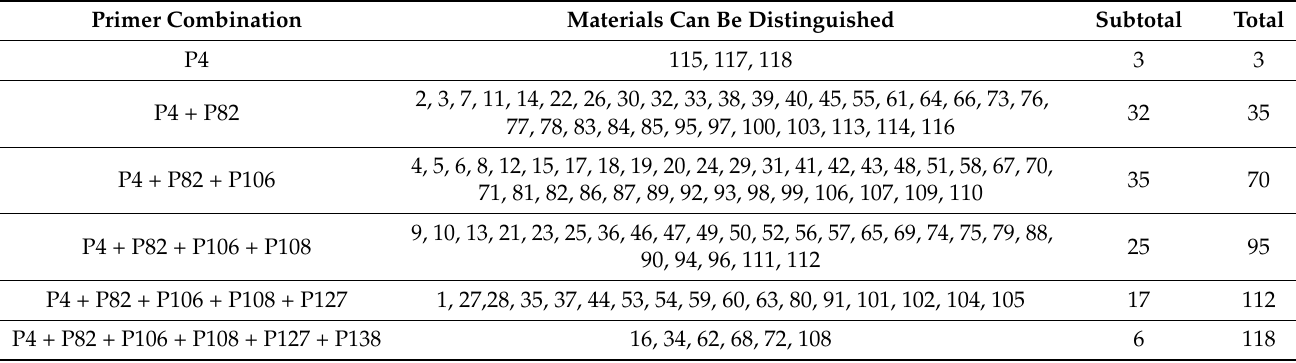
Table 3. Materials distinguished using a gradually increasing number of primer